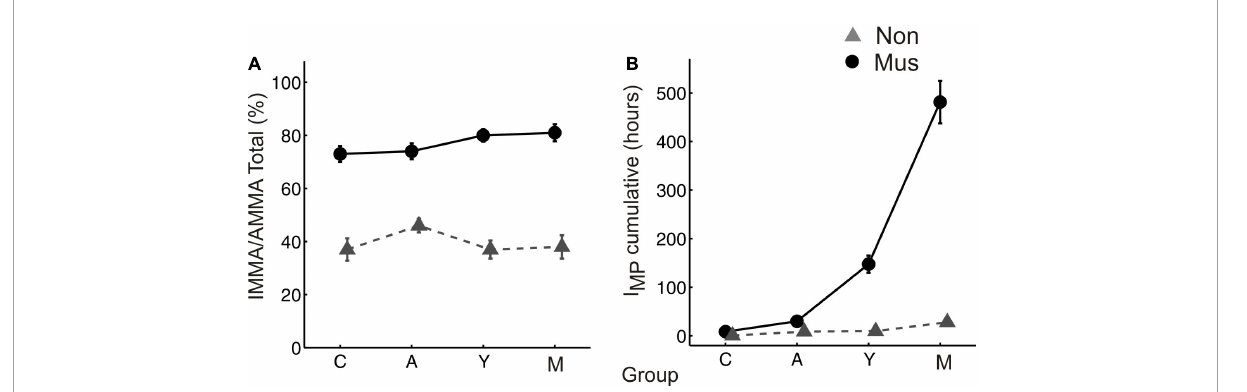
FIGURE1 Musical aptitude and cumulative amount of musical training (A) group-averaged perceptual score of the IMMA/AMMA-tests, (B) group-averaged I MP values. The bold solid lines (circles) depict the values of the musicians, the dashed lines (triangles) those of the non-musicians. C, children; A, adolescents; Y, young adults; M, middle-aged adults. “Mus” represent the musicians, while “Non” illustrates the